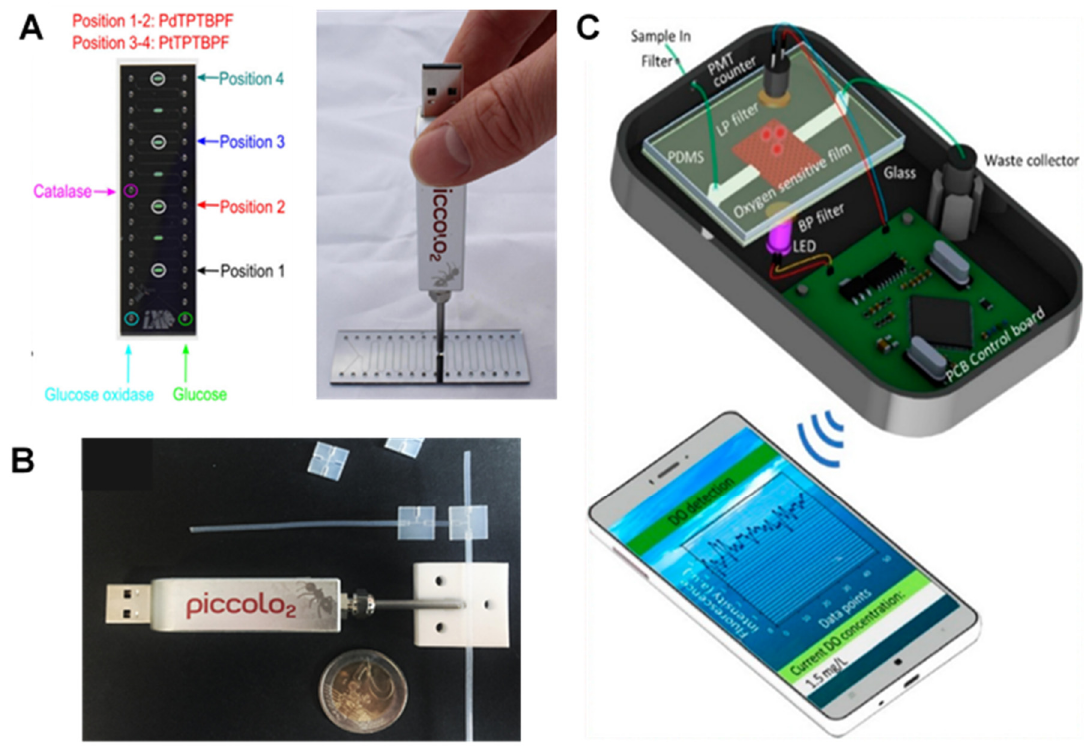
Figure 3. Commercial and portable optical readout systems for on-chip O 2 monitoring. ( A ) A chip (left) designed for commercial optical readout devices (right). Reproduced with permission [78] , copyright 2016, Elsevier. ( B ) chip-based bacteria study with O 2 measurement through the wall of tubing using a commercial readout device. Reproduced with permission [49] , copyright 2016, American Chemical Society. ( C ) A portable handheld photodetector device connected to a mobile app for chip-based O 2 monitoring. Reproduced with permission [80] , copyright 2021, MDPI.